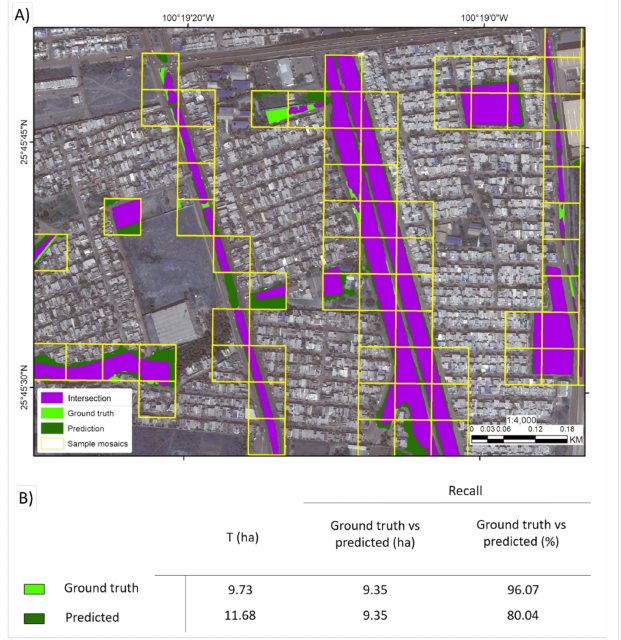
Figure 9. Model assessment. ( A ) The overlap coverage between the polygons produced from the CNN model and the ground truth data. ( B ) Recall analysis. T is the total coverage. Ground truth vs predicted columns show the area in ha and proportion of positives identified